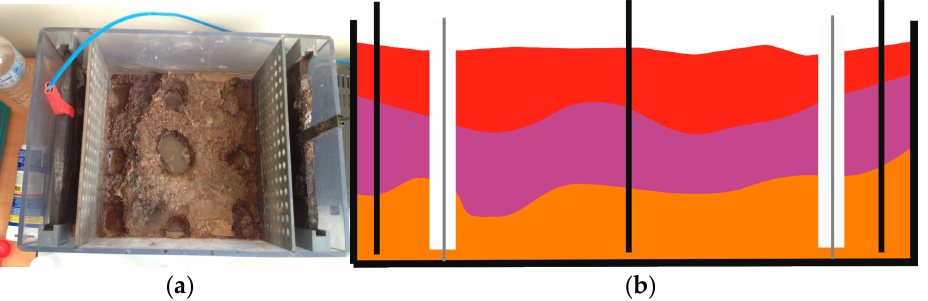
Figure 1. Details of electrokinetic cell with the position of (Olicio) soils samples ( a ) and Schematic cross section of Nitrastur laboratory test cell ( b ).